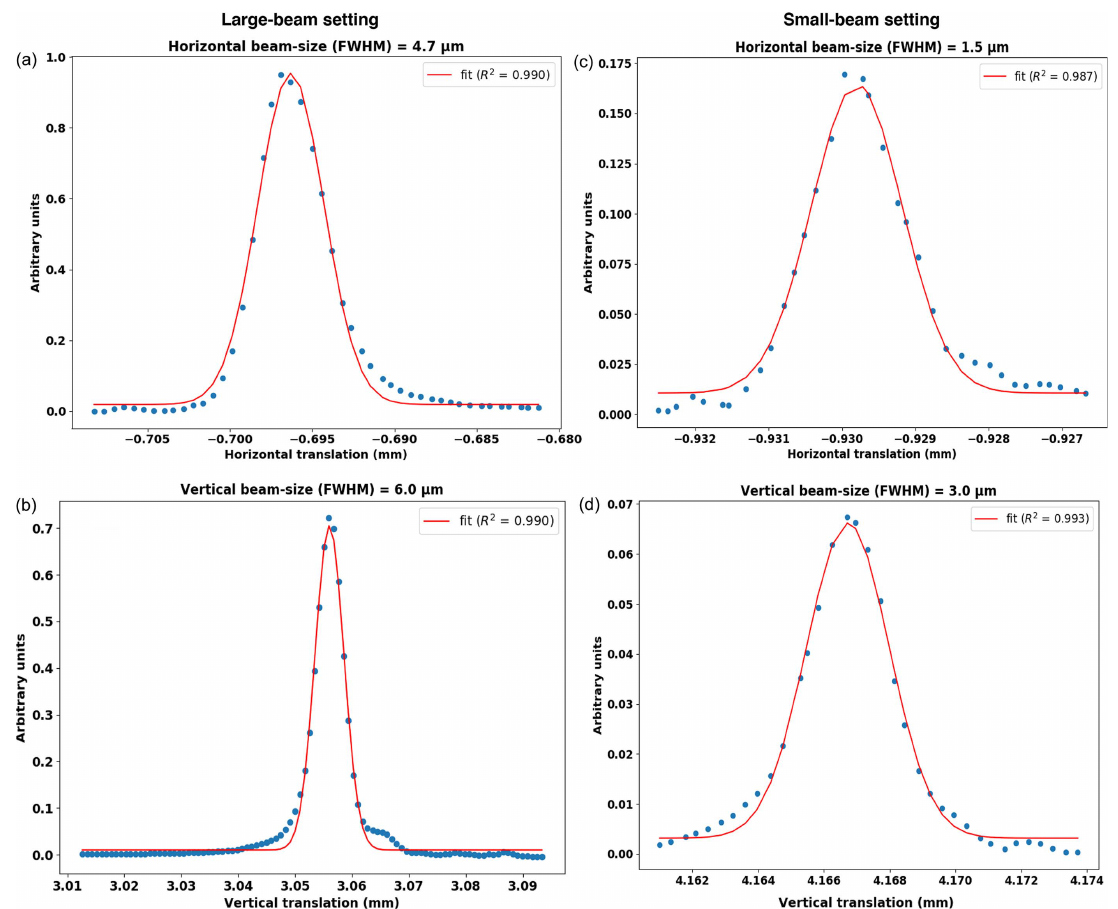
Figure 3 Beam sizes in FWHM, measured by a knife-edge scan of a 5 m m tungsten wire through the X-ray beam ( a ) and ( c ) horizontally or ( b ) and ( d ) vertically with readout from a downstream calibrated PIN diode. Fitting was performed in PyMCA